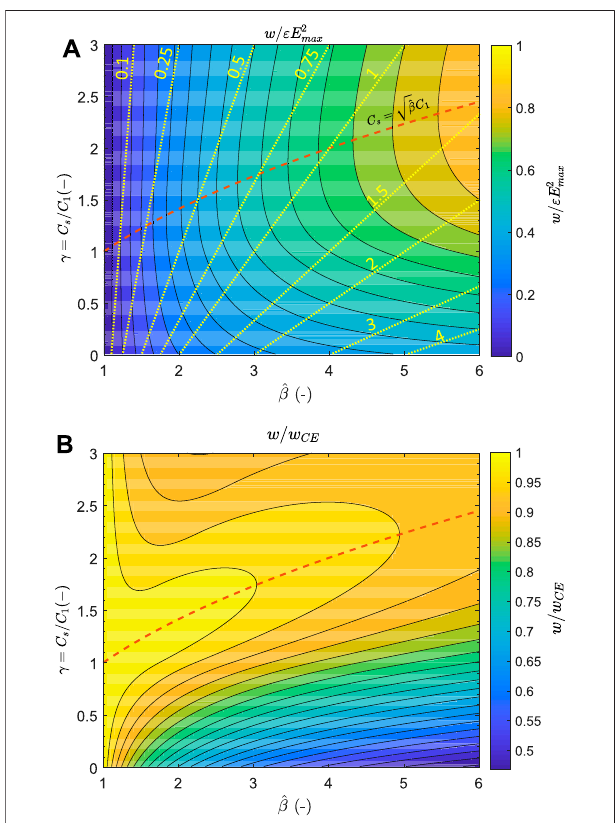
FIGURE 5 | Normalised harvested energy density (A) and harvested energy density relative to the constant electrical fi eld cycle (B) as a function of thecapacitance swingandvalueofthestoragecapacitor. Thereddashedline represents the optimal value of C s , and the yellow lines represent the ratio of the harvested energy with respect to the priming